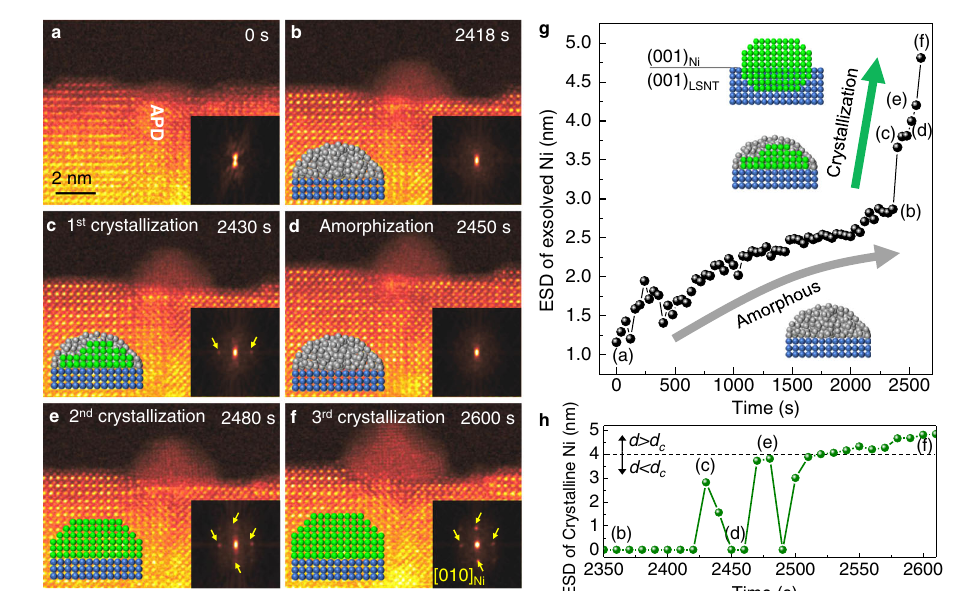
Fig. 5 | Time-resolved in situ STEM imaging of NP formation process. a – f Sequential STEM-HAADF images showing the evolution of crystalline Ni NP on top of APD via TSC. Insets are FFT patterns obtained from the Ni NP. The yellow arrows in FFT patterns indicates the re fl ections from Ni NP. The in-plane lattice fringes appeared fi rst in c . g Time-dependent evolution of the size of Ni NP. The equivalent spherical diameter (ESD) of NP was measured directly on time-series of STEM images. The time corresponding to the STEM images in a – f are denoted accordingly.Theamorphousdropletwasformed fi rst.Subsequently,thecrystalline phaseisstabilizedafterseveralstructural fl uctuations.Oncethecrystallinephaseis